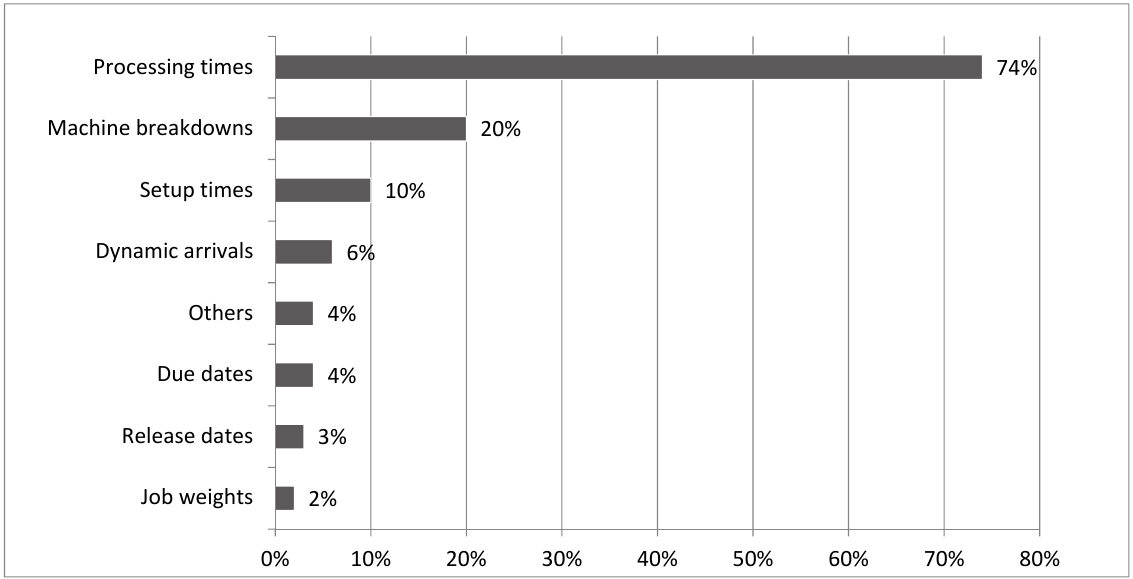
Fig. 3. Distribution of parameters under